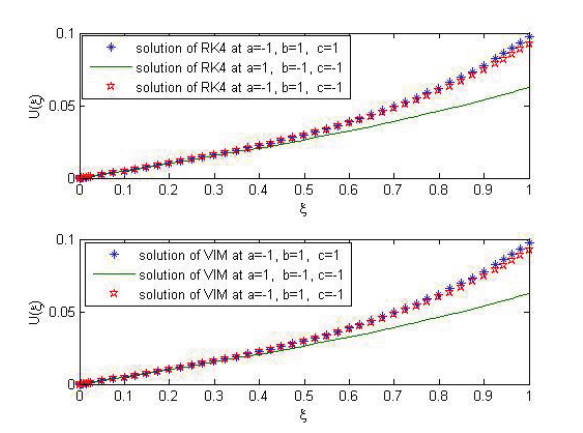
Fig. 2: The behavior of the approximate solution using RK4 (Top) and VIM (Bottom) with different values of a , b and c .